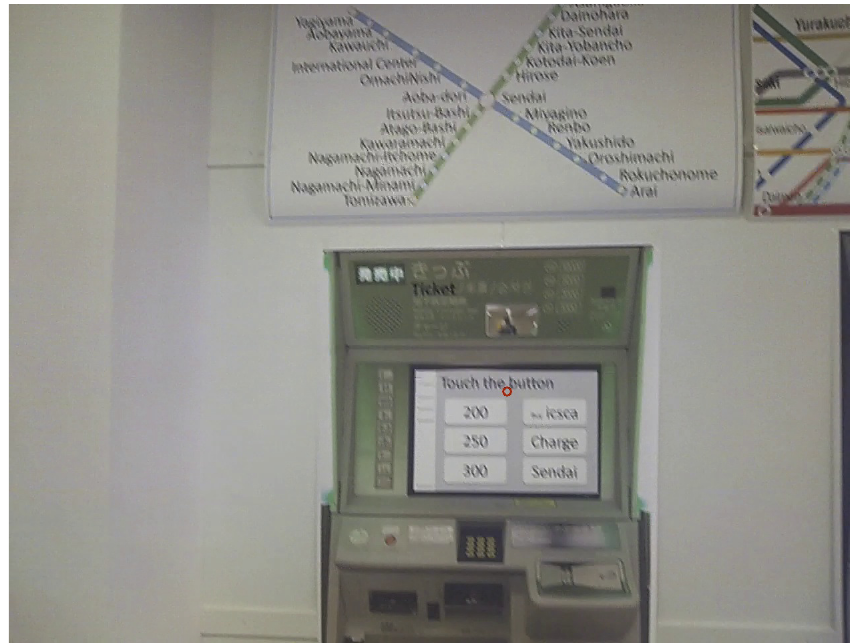
Figure 6. Example of failure caused by motion